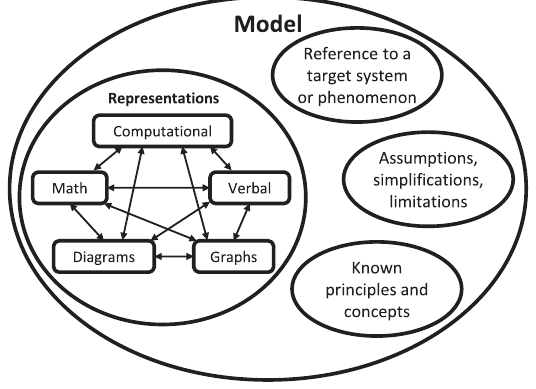
FIG. 1. Key components of a well-defined model include articulation of a target system, assumptions, key principles, and external